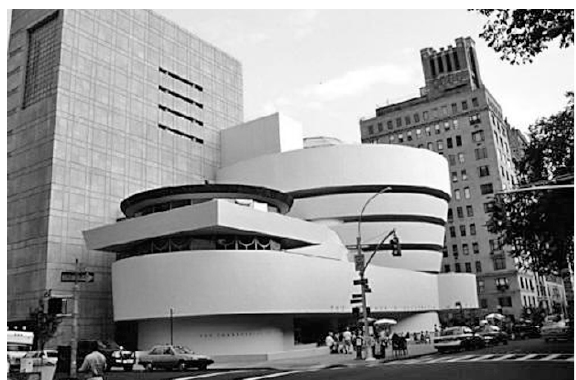
fig. 1. new York Guggenheim Museum